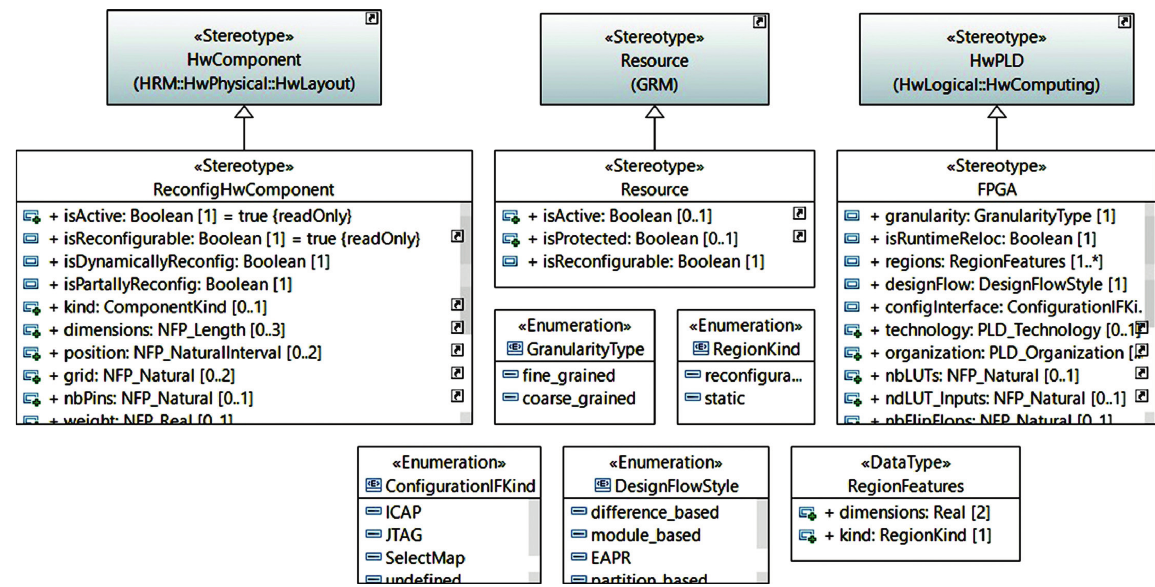
Figure 10: Extended HRM GRM